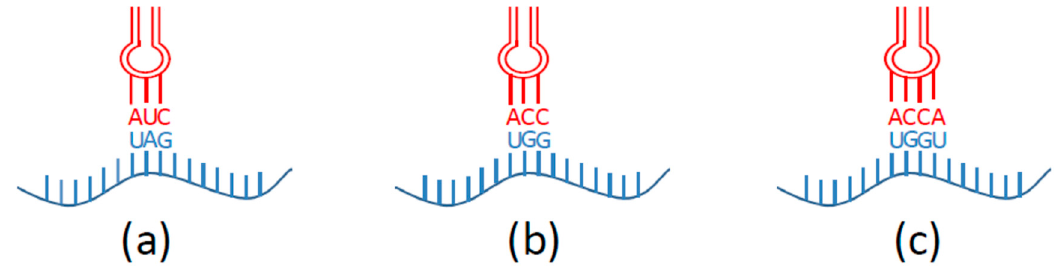
Figure 2. Scheme of nonsense ( a ), sense ( b ) and frame-shift ( c ) suppression demonstrates the interaction of mRNA with orthogonal tRNA.